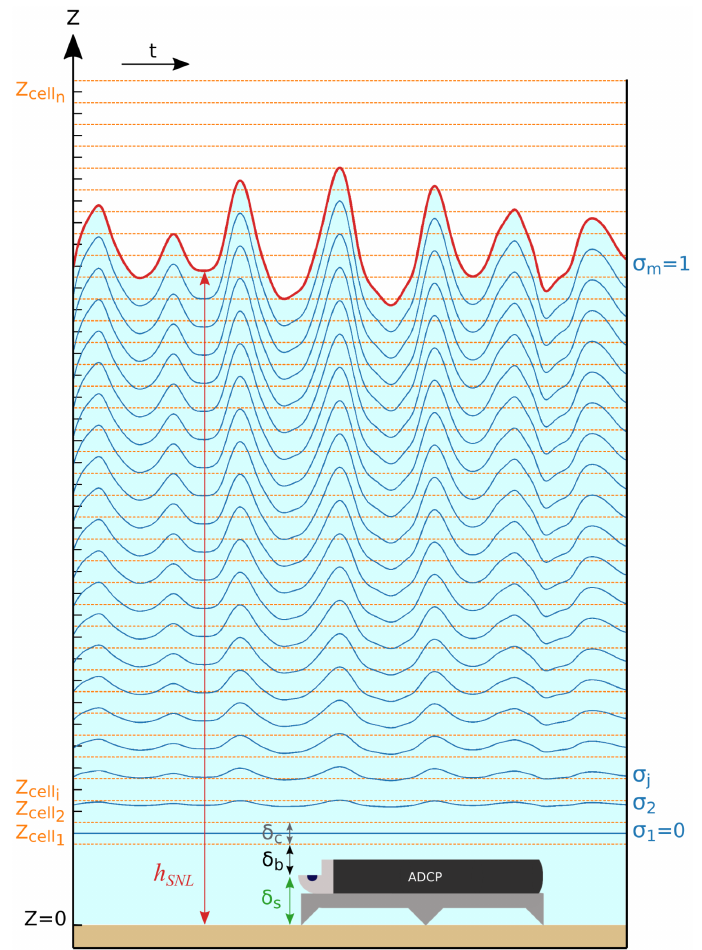
Figure 3. Sketch showing the ADCP velocity measuring positions throughout the water column in terms of vertical cells ( z cell ) and σ layers. The red line ( h SNL ) represents the reconstructed water depth time evolution. δ s indicates the pressure sensor height (green line) with respect to the bottom. The velocity profile is measured after a blanking distance ( δ b ; black line) from the instrument. The measurements are assigned to the middle of each cell ( δ c = cell size) delimited by the orange dashed lines. The blue lines represent the user-defined σ layers normalized by the distance between the first cell and the water surface. σ layers are designed to follow the irregular shape of the water surface at different elevations of the water column. Velocities measurements at these positions are obtained by interpolating the vertical cells’ velocity